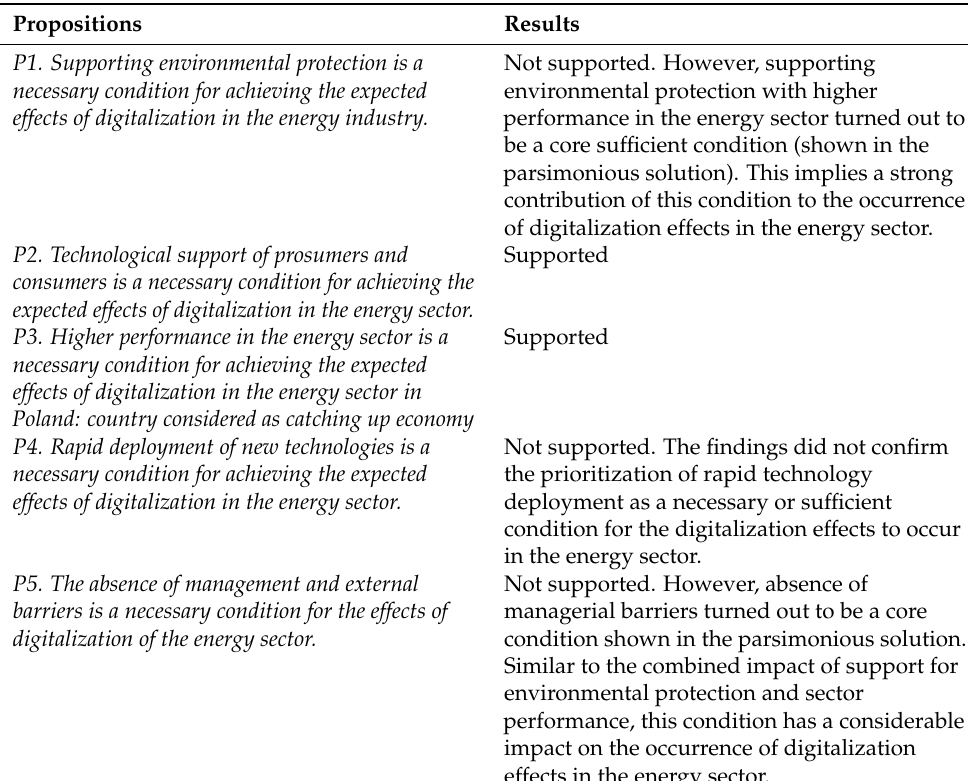
Table 9. Research propositions and their confirmation